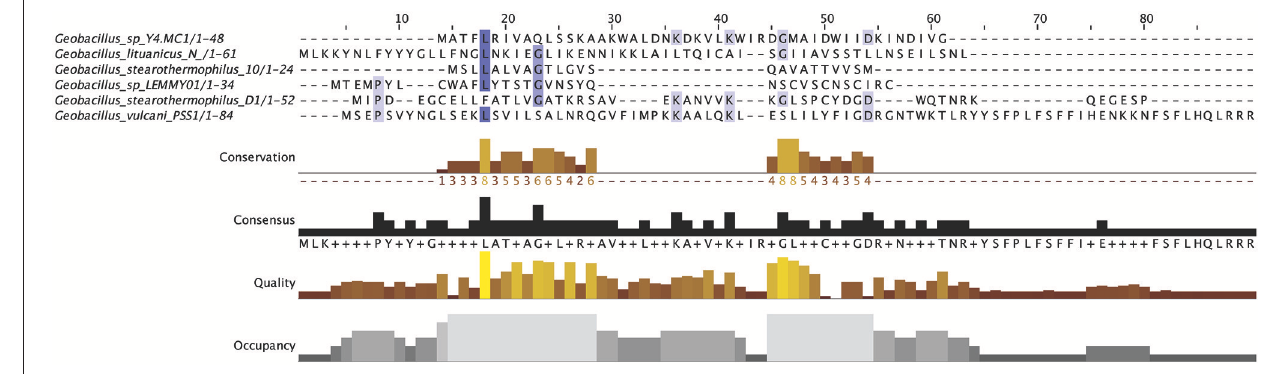
FIGURE 12 | MSA of Class II bacteriocins predicted by BAGEL3.